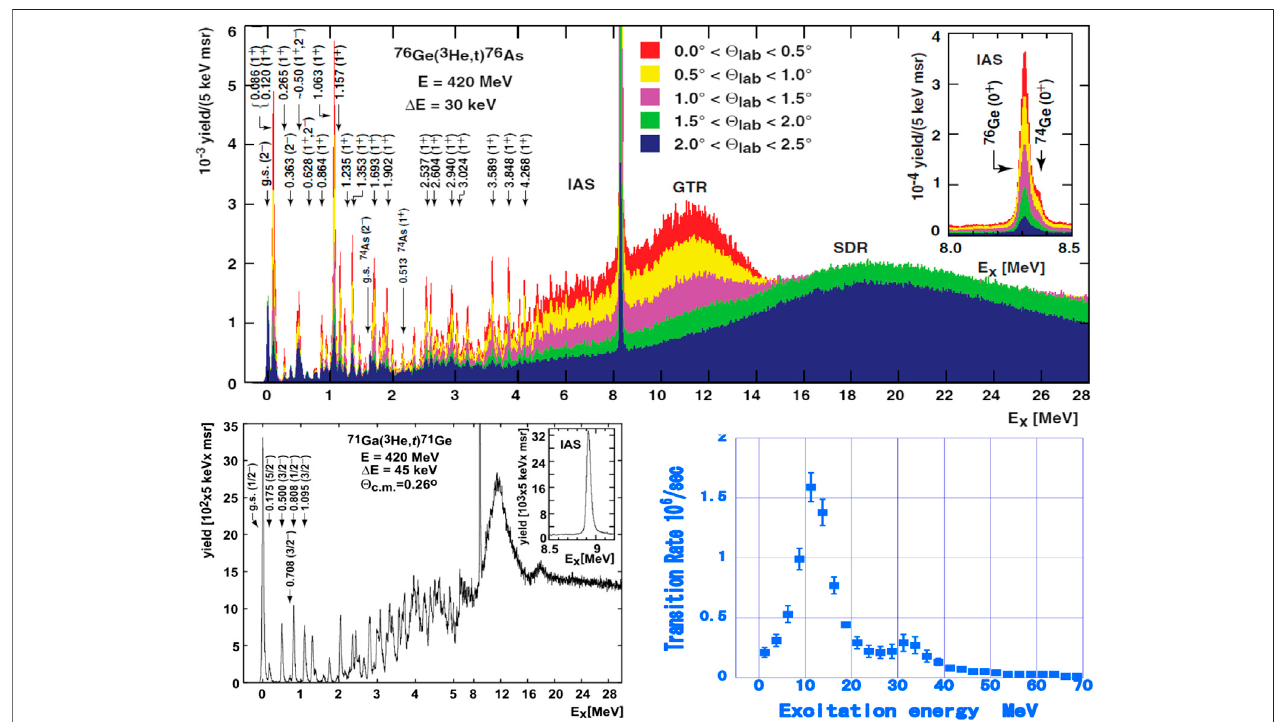
FIGURE2| CERstrengthsasafunctionoftheexcitationenergy.Top:The 76 Ge( 3 He,t) 76 Asreactionfor ββ responses,wheretheGT s-wavestrengths(redlines)are preferentiallyexcitedattheforwardangles,whileSDp-wavestrengths(bluelines)atlargerangles[13].Bottomleft-panel:The 71 Ga( 3 He,t) 71 Gereactionforsolarneutrino responses [14]. Bottom right-panel: The 100 Mo ( μ , ] μ ) Nb reactions [20]. The strong GT and SD giant resonances, GTR and SDR, at around 12 and 20 MeV are seen in the spectrum of 76 Ge( 3 He,t) 76